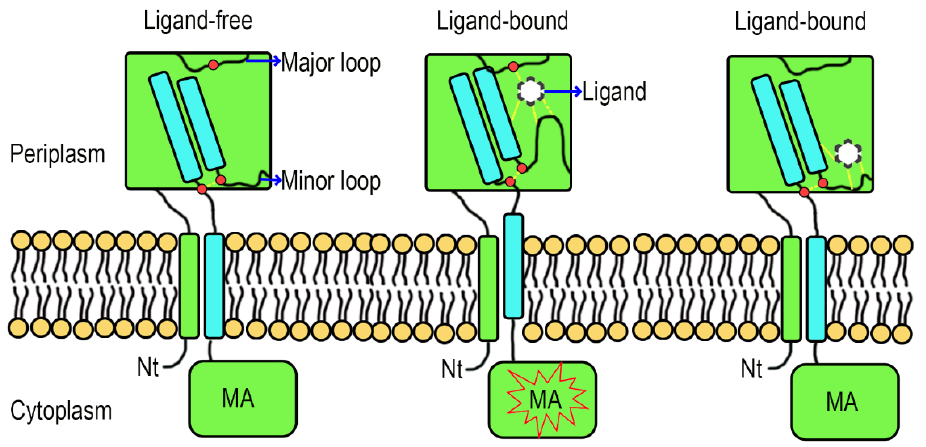
Figure 8. A hypothetical signal transduction model of Atu0526. The formic acid anchors to the anchorage residues (such as R115) and pulls the minor loop upward to realize chemotactic signal transduction. When the anchorage residues are not enough, the ligand may be able to bind to Atu0526, but it is not sufficient to induce a conformational change for chemotactic signal transduction. The red dot above refers to anchorage residue(s), and the two red dots below refer to the C-terminal residues of the fourth β -sheet and the nearby minor loop residues. The force between ligand and Atu0526 or between two residues is indicated by yellow dashed lines.